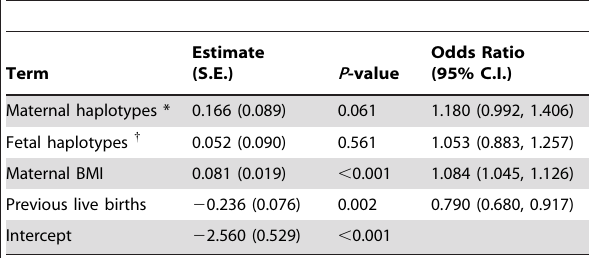
Table 4. Logistic regression model of primary risk factors for preeclampsia including COMT haplotype specified according to reported enzymatic